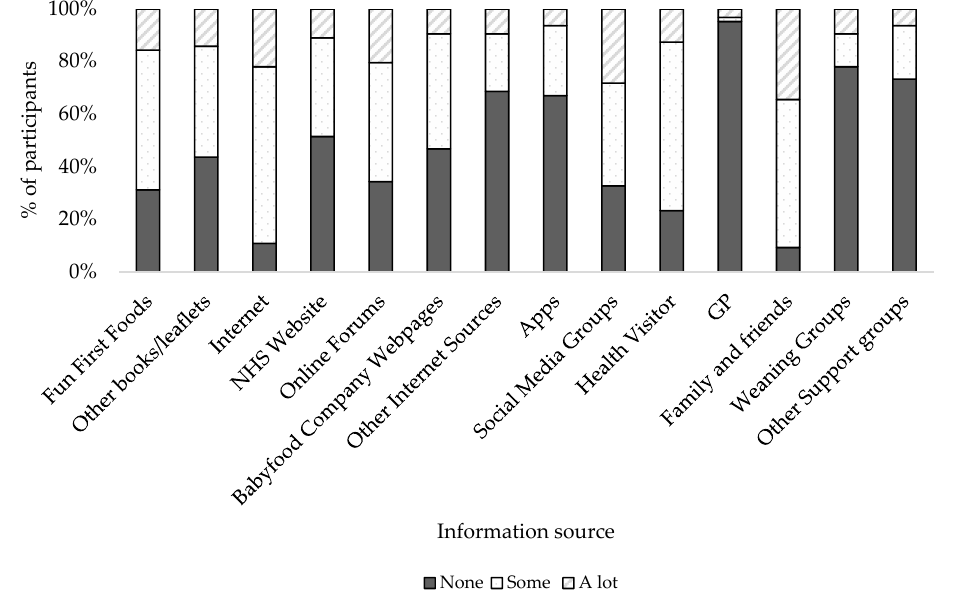
Figure 1. Percentage (%) of parents reporting the amount of information (none, some, a lot) they received from each information source.